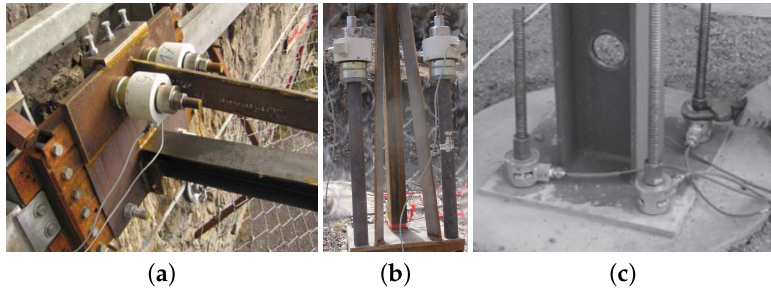
Figure 5. ( a ) Pressure load cells with load distribution ring and ball scraper to measure tension forces on anchors directly between ground plate and anchor nut and ( b ) with pipe elongations in case the space on the ground plate is too small for the load cells; ( c ) shows a setup with four load cells (source: [16]).